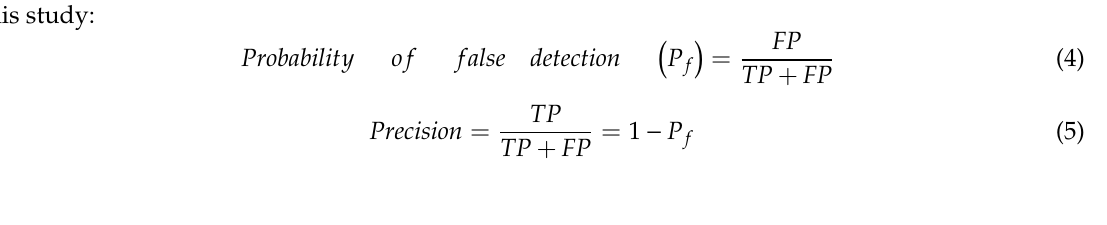
Figure 6. Comparison between the semantic segmentation label image and object detection label image with corresponding Extensible Markup Language (XML) data. The red rectangle denotes the bounding box of the ship. The bounding box information (xmin, ymin, xmax, and ymax represented the position of the bounding box) is provided in the XML file.